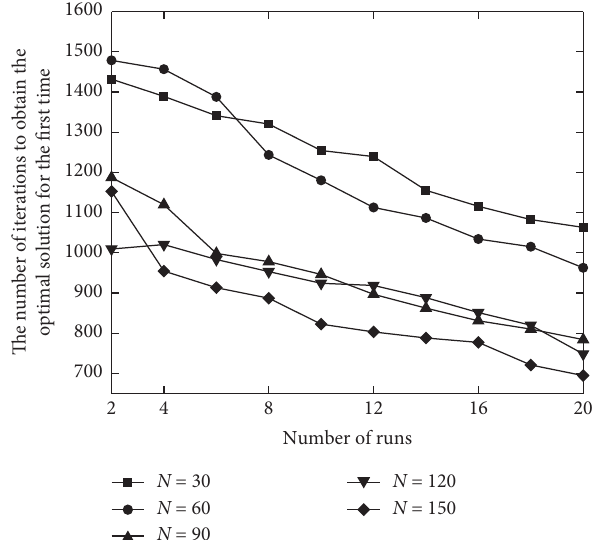
Figure 8: The number of iterations to obtain the optimal solution for the first time under different population